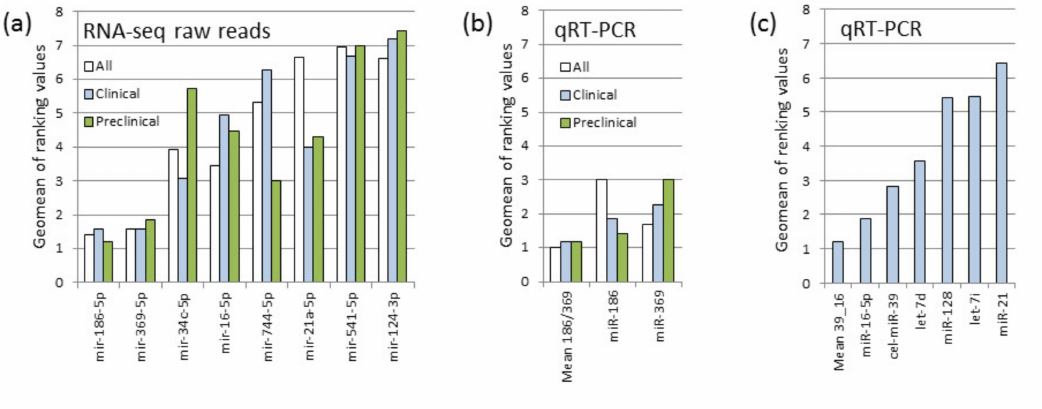
Figure A1. Evaluation of reference genes for qRT-PCR